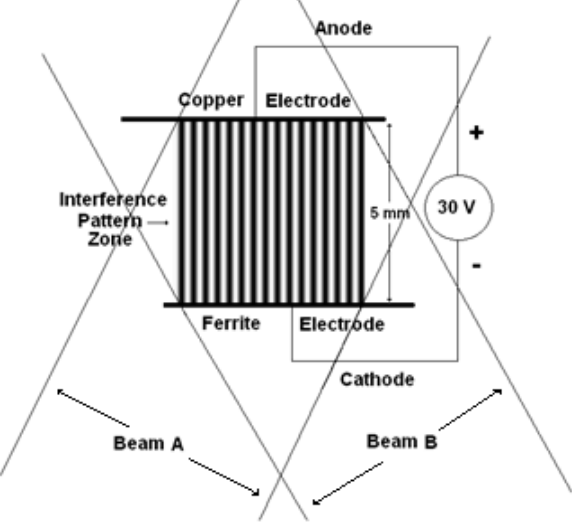
Figure 4. Scheme of experimental design for electrodes connection with the material where the interference pattern is formed due to holographic